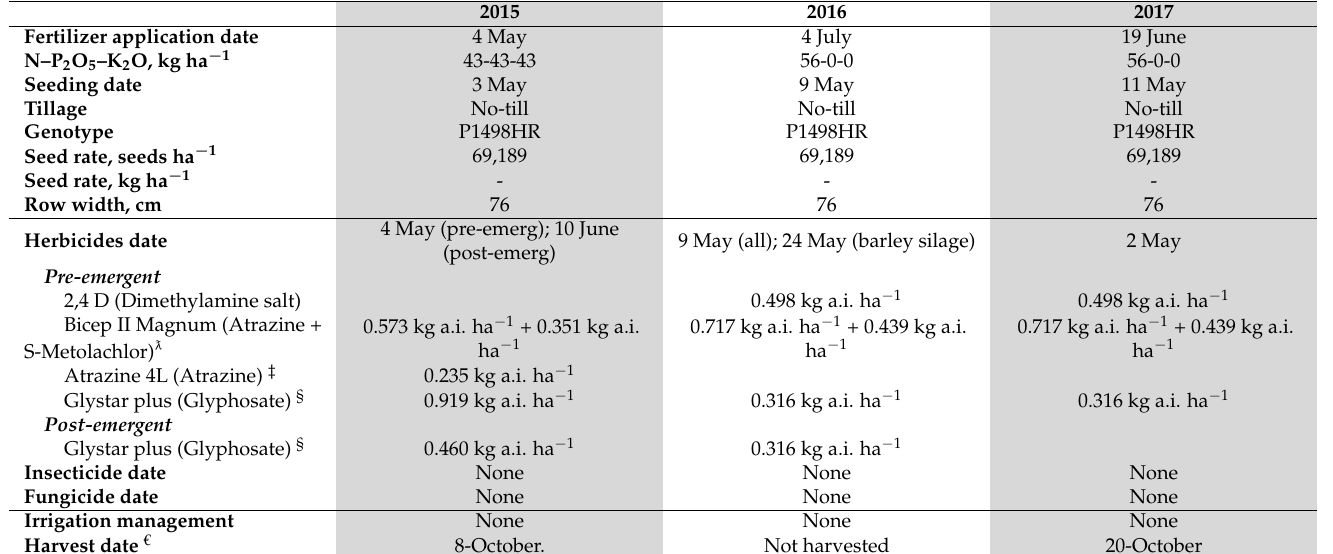
Table 2. Detail of the management practices applied to continuous corn in the period 2015–2017 at Kentland Farm, Blacksburg, VA,